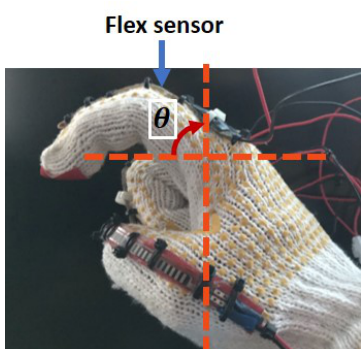
Figure 3. A preliminary analysis to investigate the correlation between the sensor output voltage and the bending angle when the sensor is tied on a cloth glove.